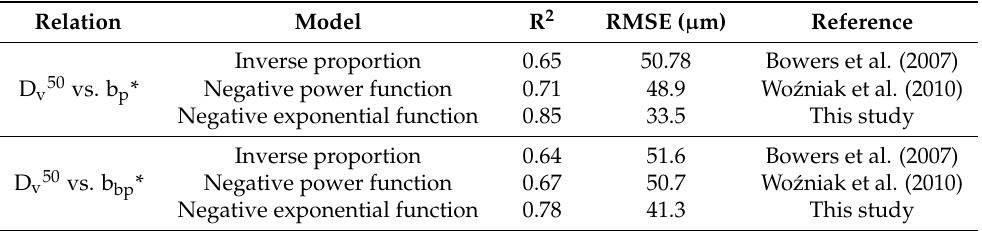
Table 3. Comparison of Dv50 models reported by previous studies and that proposed in this study in calibration.